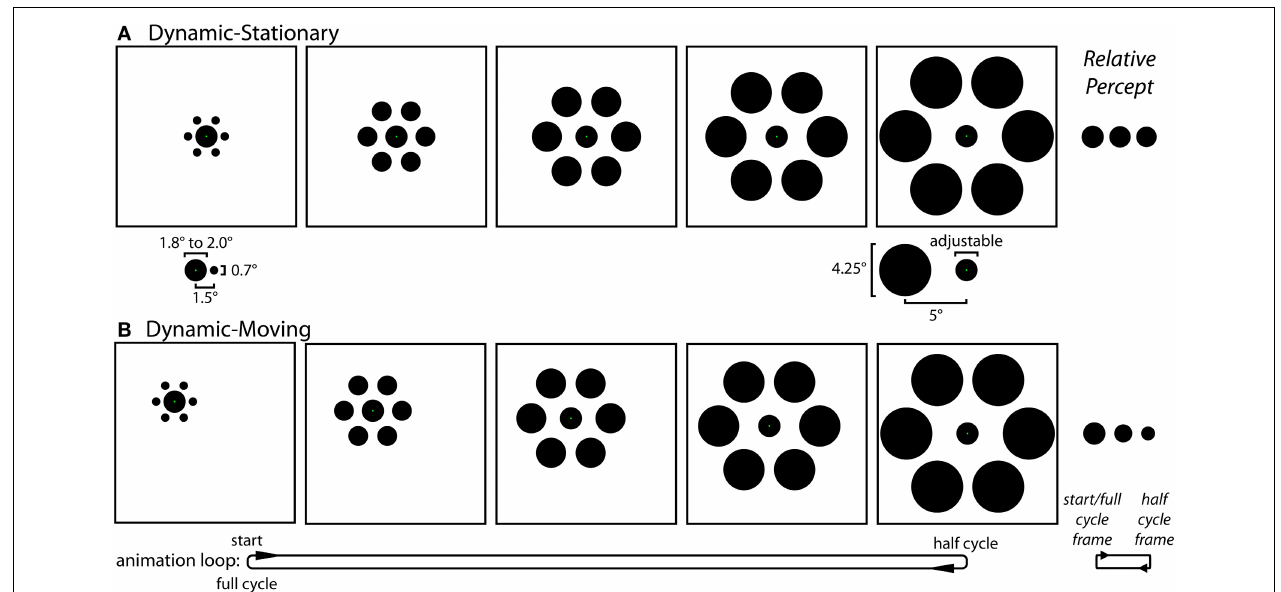
FIGURE 3 | The Dynamic conditions of Experiment 1. (A) In the Dynamic-Stationary condition (Movie 1) the inducers continuously modulate their size and eccentricity between small-and-near and large-and-far while the participant fixates a stationary central target. The relative size and eccentricity of the target and the small-and-near (left) and large-and-far (right) inducers used in all conditions of both experiments are shown below their respective frames. (B) In the Dynamic-Moving condition (Movie 2) there is an additional translation of